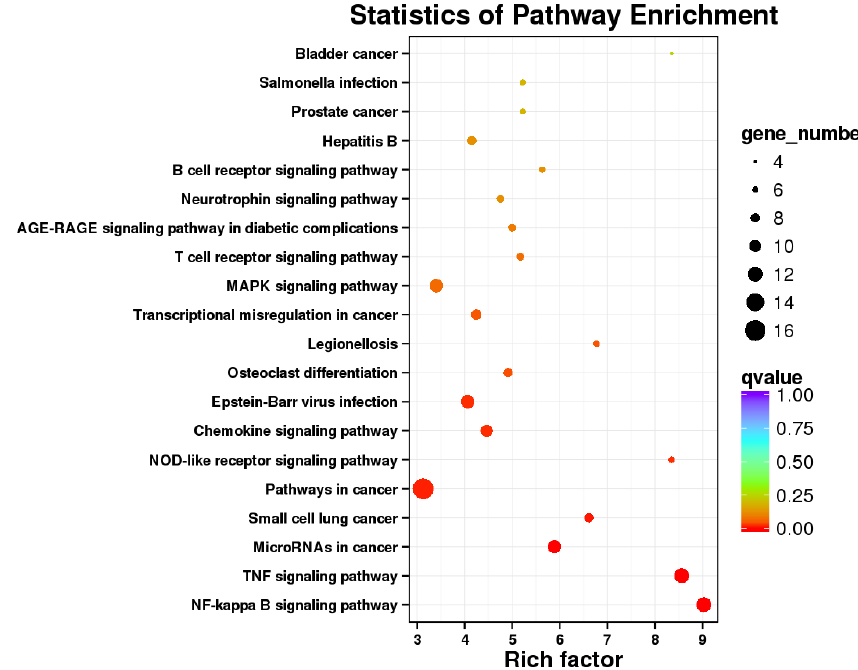
Figure 3. KEGG pathway analysis of DEGs between the control and E. coli groups. Table 3. DEGs involved in the immune signaling pathways caused by E. coli.